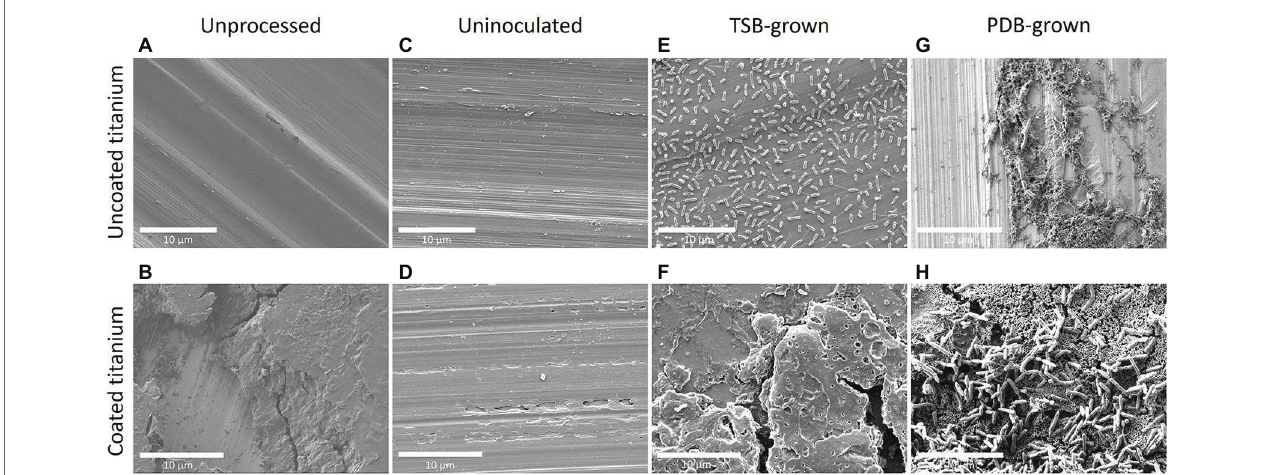
FIGURE 4 | Scanning electron microscopy (SEM) imaging of P. aeruginosa biofilm formation on titanium after 48 h. Images (A,B) represent uncoated and coated titanium that were unprocessed (not exposed to the reactor, bacteria, or SEM preparation steps). Images (C,D) represent uncoated and coated titanium that were not exposed to the reactor or bacteria but went through the SEM preparation steps at the JPL. Images (E,F) represent uncoated and coated titanium that came from a reactor that utilized TSB medium while (G,H) came from a reactor with PDB. Biofilms on uncoated materials hosted numerous cells with small amounts of dried EPS attaching the cells to each other and to the surface.